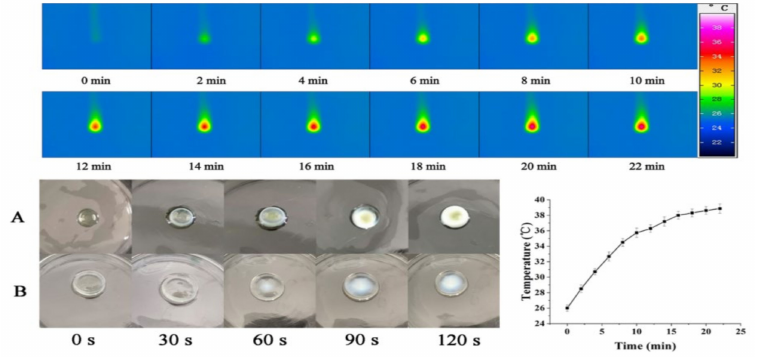
Figure 7. Temperature curve of CuS nanoparticles under 808 nm near-infrared light and photothermal performance. ( A ) The hydrogel loaded with CuS nanoparticles, ( B ) The hydrogel loaded without CuS nanoparticles.